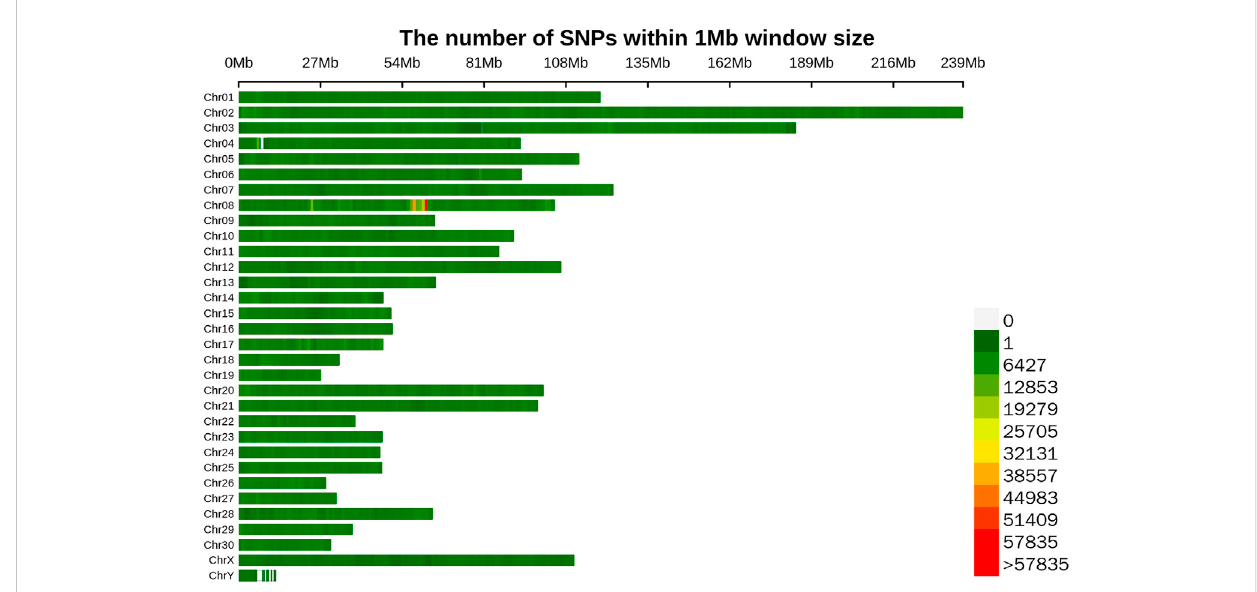
FIGURE 1 Distribution map of SNPs on different chromosomes. Different colors represent the number of SNPs in the 1 Mb window.